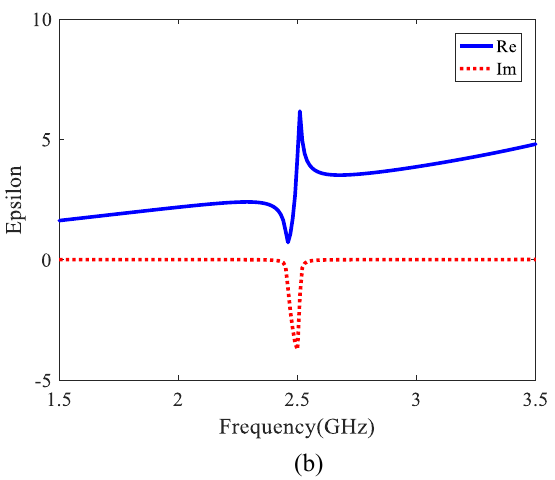
Fig.2 The proposed metamaterial structure between the two waveguide ports.